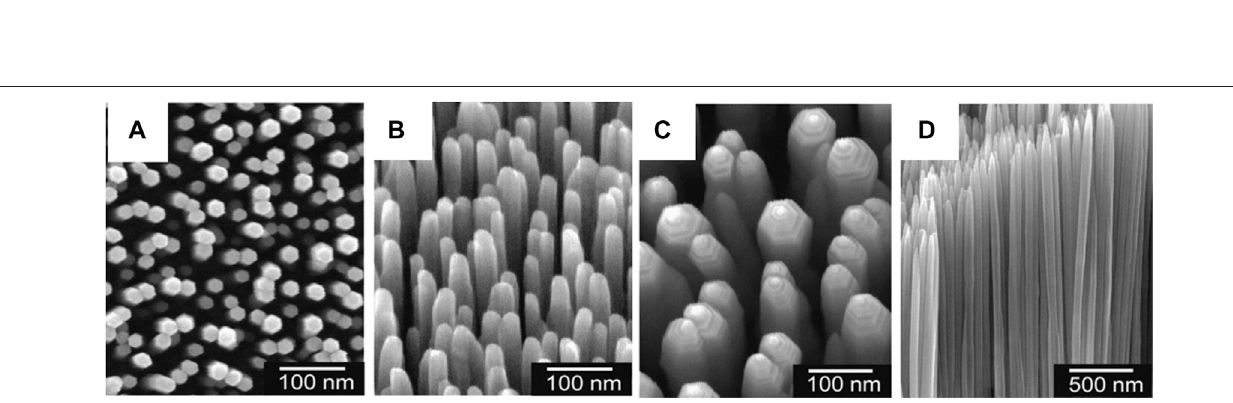
FIGURE 11 | FESEM images of Aligned ZnO nanorods (Park et al., 2004).